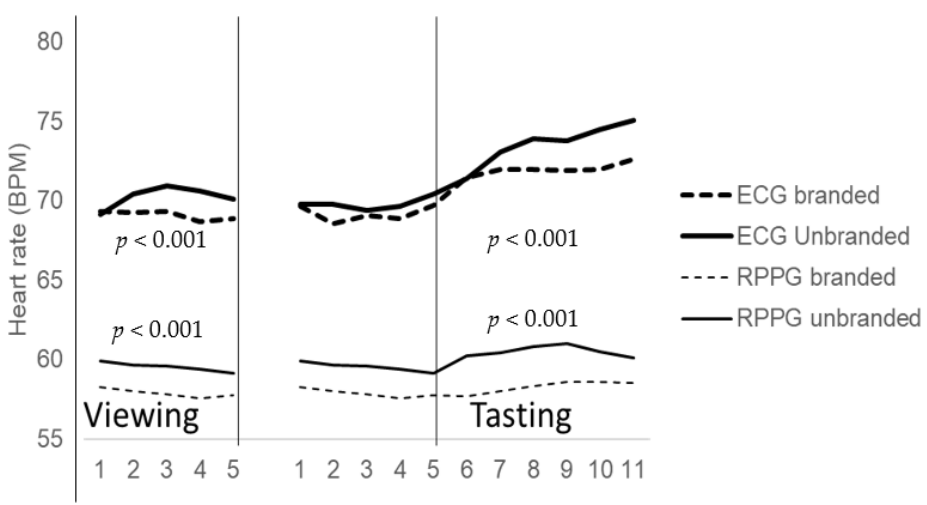
Figure 3. Heart rates measured by ECG and RPPG during 5 s of viewing, 5 s of anticipation between viewing and tasting, and 6 s of tasting (6–11 s) of unbranded (solid line) and matched branded (dashed line) stimuli. Significance levels of branded/unbranded differences are indicated by p -values.